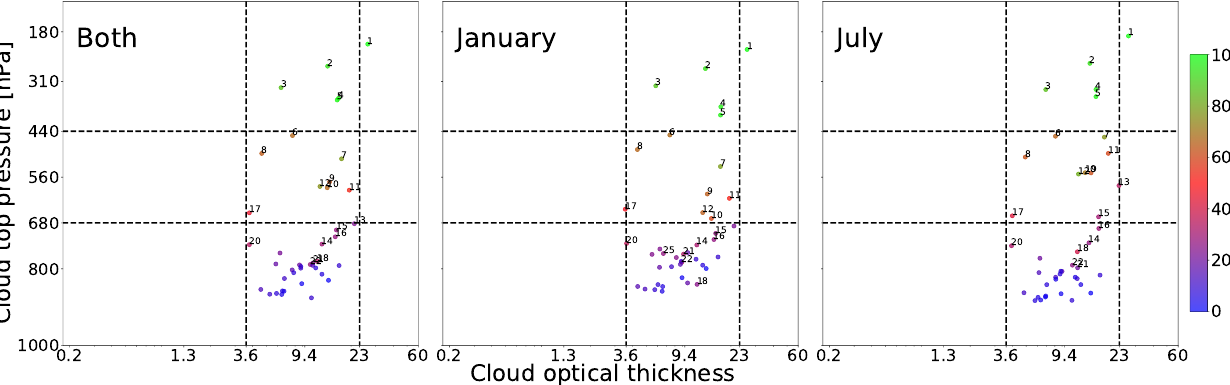
Figure 7. Test of whether AICCA 42 captures expected variations in cloud microphysics, i.e., the ice and liquid fractions for individual cloud classes. The figure is constructed in the same way as Figure 5, but with each color marker now showing the cluster’s mean ice phase ratio , defined as the mean within-cluster percentage of cloud pixels denoted as ice phase. We omit all pixels labeled as “undetermined” in MOD06; many of these are internally mixed phase but the proportions cannot be determined. AICCA 42 cloud classes are sufficiently restricted that they capture the expected microphysics, with higher ice fractions in higher-altitude